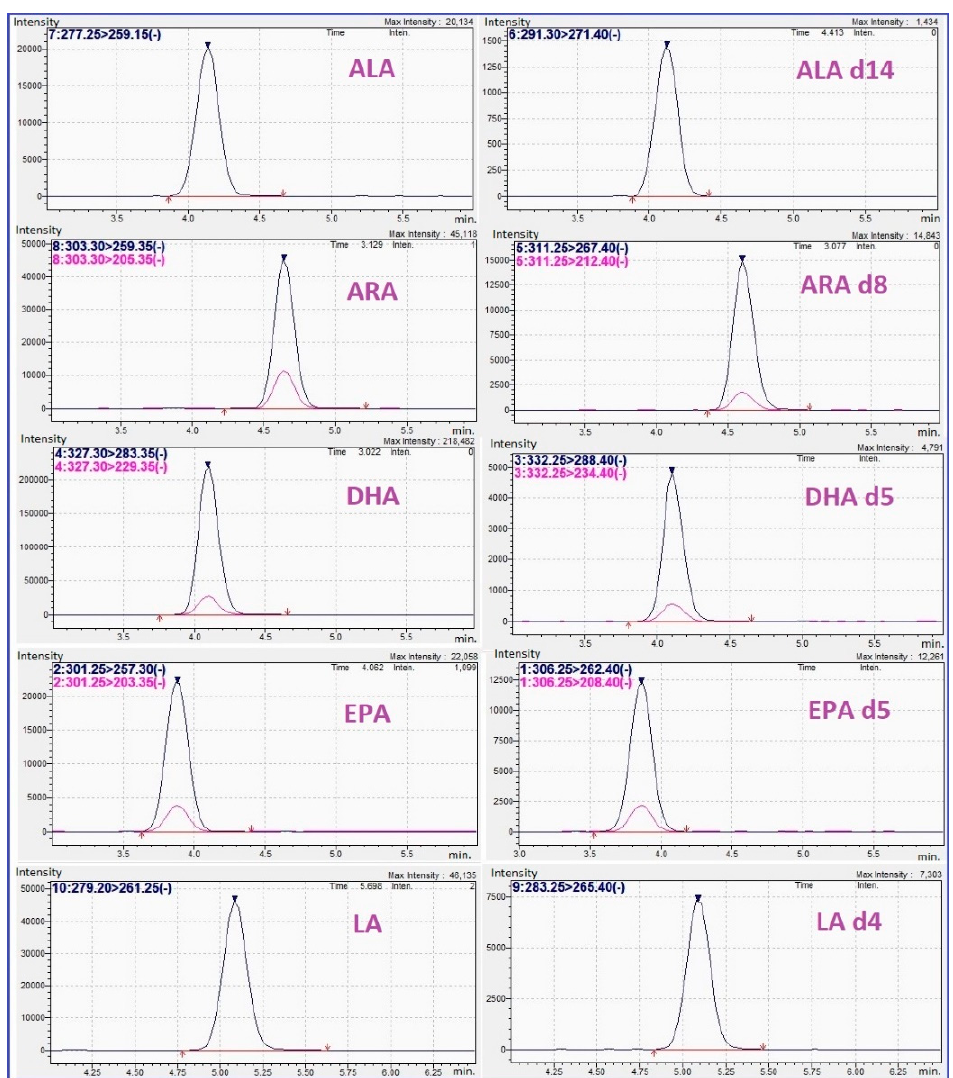
Figure 1. Multiple reaction monitoring (MRM) chromatograms of ALA, ALA-d14, ARA, ARA-d8, DHA, DHA-d5, EPA, EPA-d5, LA, and LA-d4 standards at concentration of 0.016, 0.2, 0.08, 0.1, 0.016, 0.1, 0.016, 0.1, 0.08, and 0.2 µ g/mL respectively. Legend: ALA— α -linolenic acid,